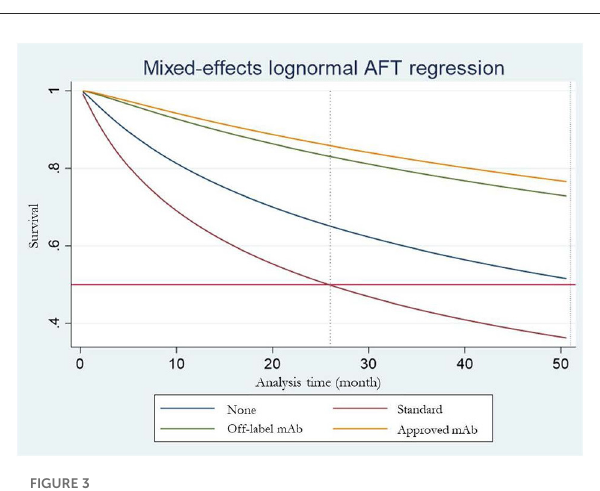
FIGURE3 Estimated median time to first release for each treatment arm.